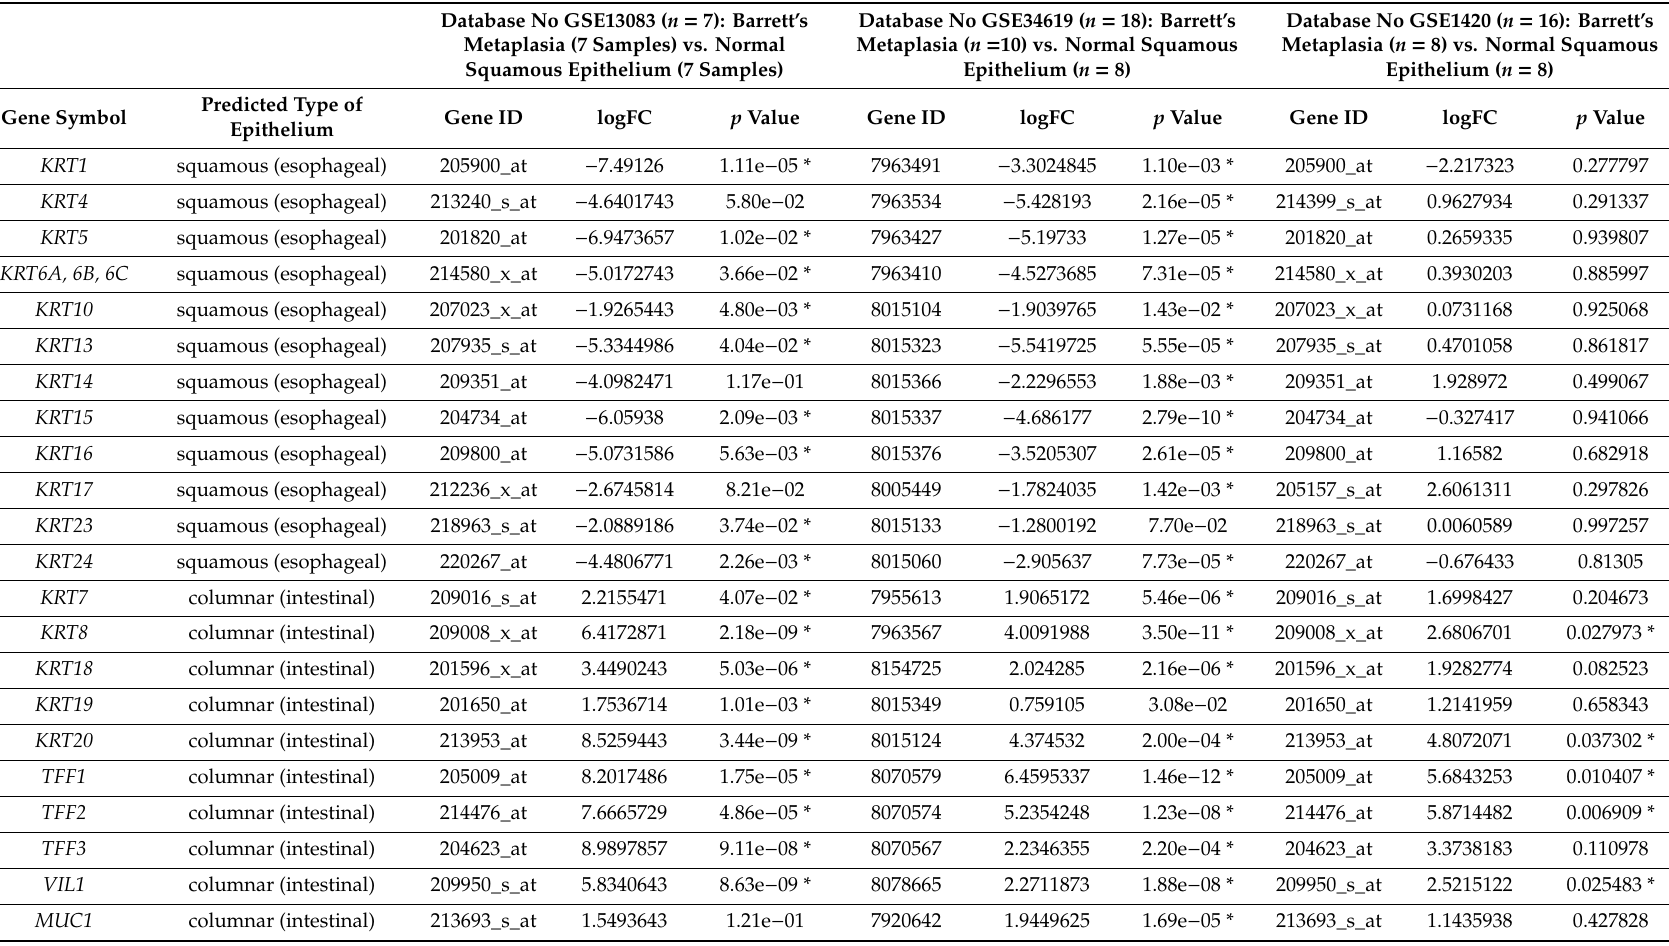
Table 1. Alterations in selected genes expression in human biopsies derived from patients with Barrett’s metaplasia as compared with normal squamous epithelium, based on analysis of the database no GSE13083 [8], GSE34619 [9] and GSE1420 [24]. Asterisk (*) indicates statistically significant di ff erence with p < 0.05 in parallel with logFC values lower than − 2 or higher than